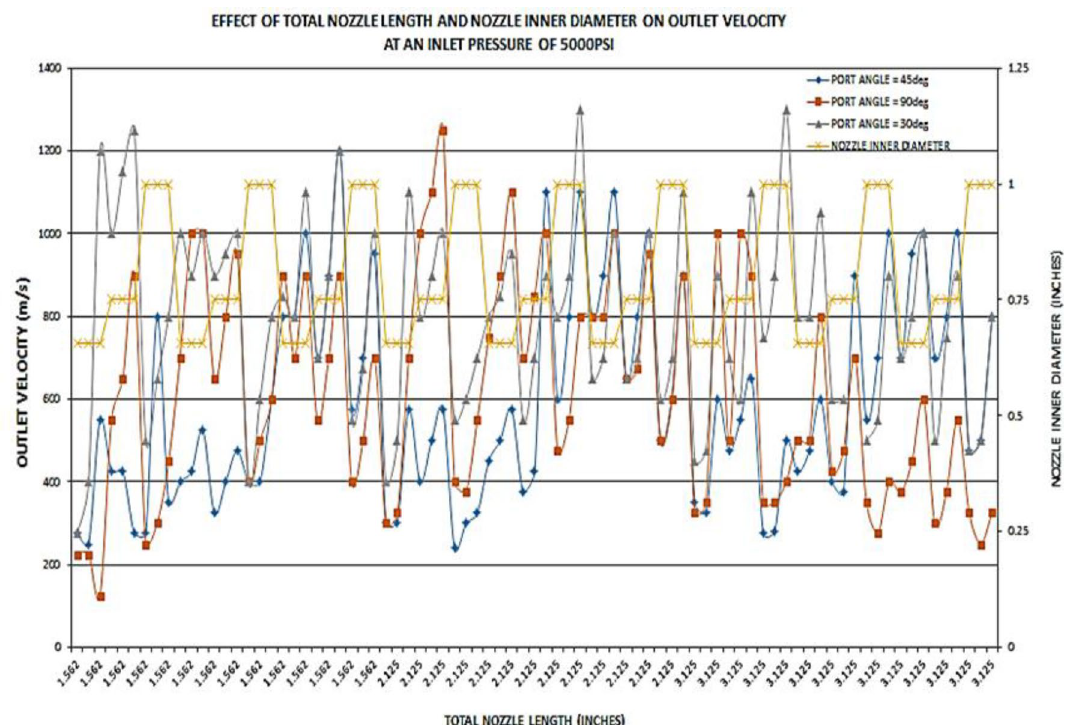
Fig. 14 Effect of total nozzle length and nozzle inner diameter on outlet velocity at an inlet pressure of 5000